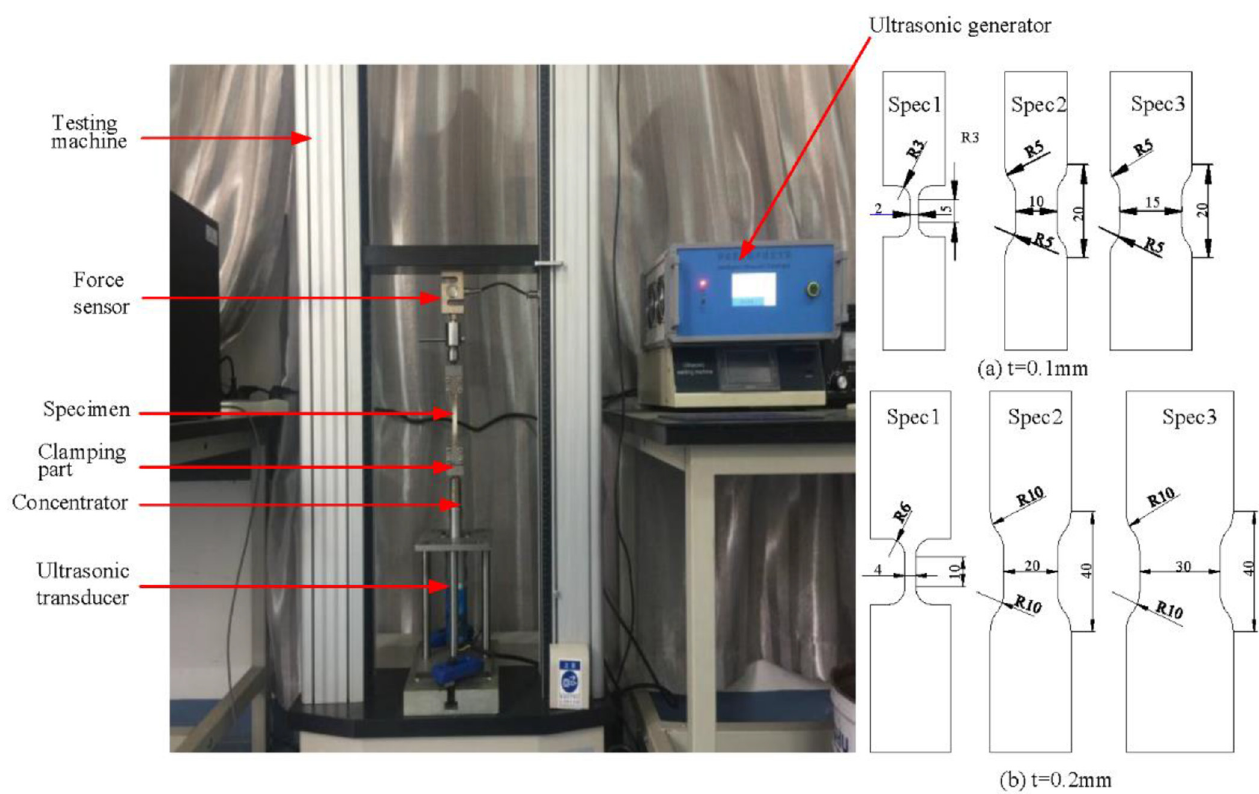
Fig. 2. Uniaxial tensile testing device of forming limit based on ultrasonic